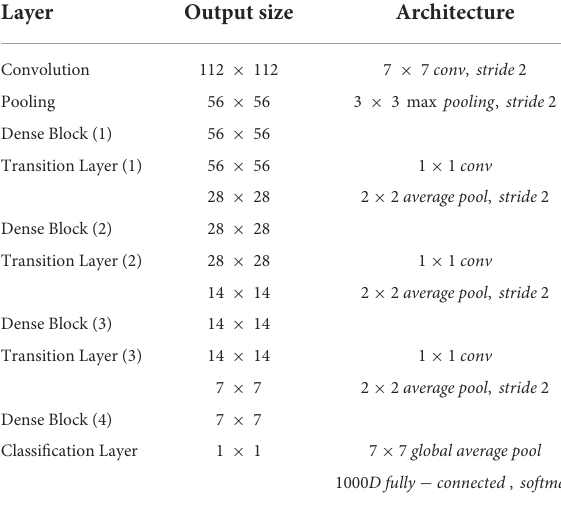
TABLE 3 The network backbone of the AI-100